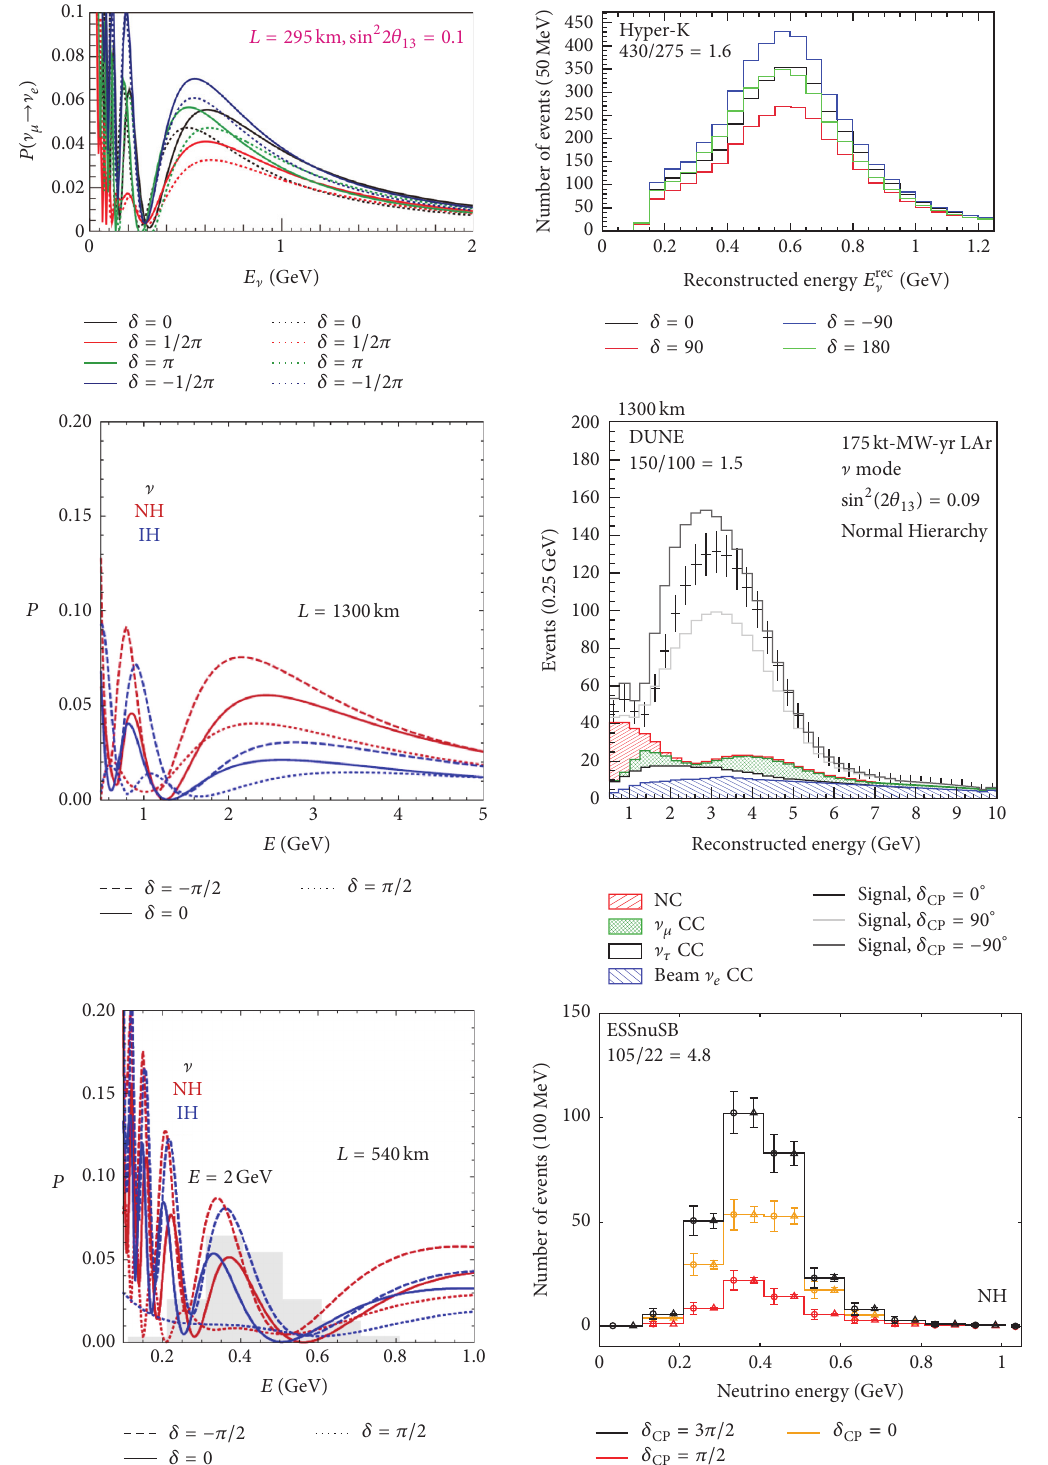
Figure 4: The histograms in the panels in the right hand part of the figure show, for the three different neutrino beam projects Hyper-K [8], DUNE [20, 21], and ESSnuSB, the number of detected electron neutrinos as a function of neutrino energy 𝐸 for three different values of 𝛿 CP : 0, which corresponds to no CP violation, and 𝜋/2 and 3𝜋/2 , which correspond to maximum CP violation of opposite signs, respectively. The left panels show the calculated probability for the electron neutrino oscillation for the same three 𝛿 CP values and for Normal Hierarchy (NH, red) and Inverted Hierarchy (IH, blue) [8, 21]. The shaded histogram in the left ESSnuSB panel shows the profile of the unoscillated (muon) neutrino energy distribution. The ratio between the numbers of electron neutrinos with 𝛿 CP = 3𝜋/2 and with 𝜋/2 is 4.8 for ESSnuSB and 1.6 and 1.5, respectively, for Hyper-K and LBNE/DUNE, as noted under the experiment acronym in each histogram